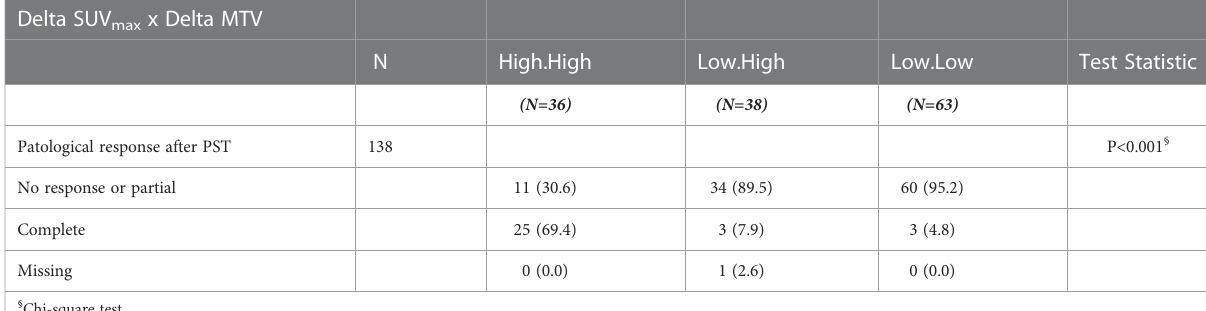
TABLE 4 Association between combined Delta SUVmax and Delta MTV evaluation and baseline clinicopathological characteristics and pCR. Delta SUV max x Delta